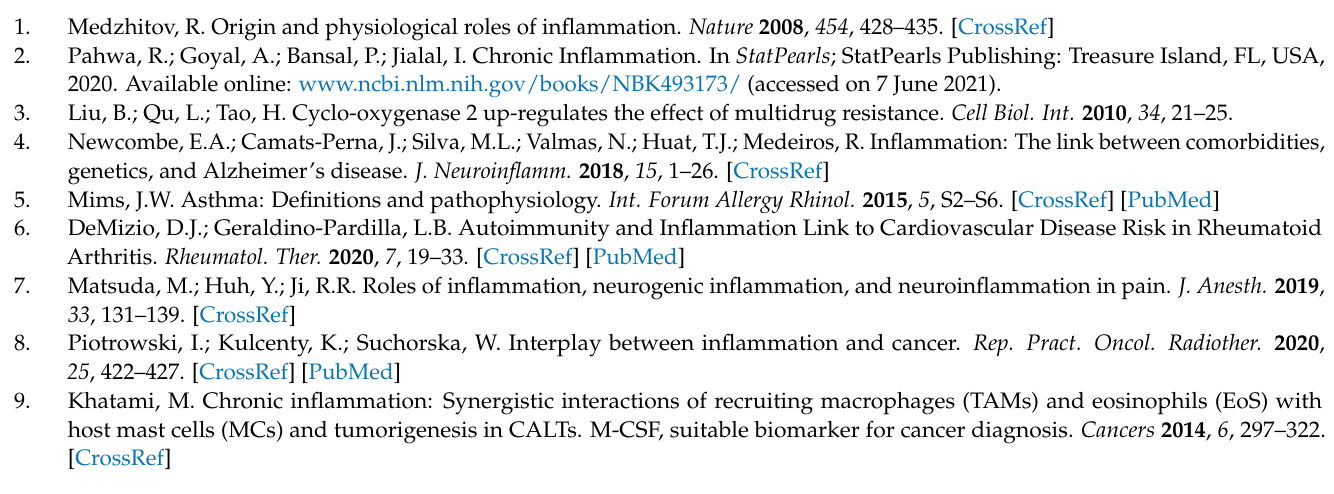
of 5 in CDCl 3 , Figure S3: 1 H NMR spectrum of 6a in CDCl 3 , Figure S4: 13 C NMR spectrum of 6a in CDCl 3 , Figure S5: 1 H NMR spectrum of 6b in CDCl 3 , Figure S6: 13 C NMR spectrum of 6b in CDCl 3 , Figure S7: 1 H NMR spectrum of 6c in CDCl 3 , Figure S8: 13 C NMR spectrum of 6c in CDCl 3 , Figure S9: 1 H NMR spectrum of 6d in CDCl 3 , Figure S10: 13 C NMR spectrum of 6d in CDCl 3 , Figure S11: 1 H NMR spectrum of 6e in CDCl 3 , Figure S12: 13 C NMR spectrum of 6e in CDCl 3 , Figure S13: 1 H NMR spectrum of 7 in CDCl 3 , Figure S14: 13 C NMR spectrum of 7 in CDCl 3 , Figure S15: The effect of 1,2-thiazine derivatives in comparison to the meloxicam on the transition half height (T 1/2 ) of the main phase transition of DPPC, Figure S16: The effect of 1,2-thiazine derivatives in comparison to the meloxicam on the transition enthalpy ( ∆ H) of the main phase transition of DPPC, Table S1: Values of DPPC phase transition temperatures (T M ) with studied compounds, Table S2: Values of DPPC transition half height (T 1 ) with studied compounds, Table S3: Values of 2 DPPC transition enthalpy changes ( ∆ H) with studied compounds, Figure S17: The intermolecular interactions between COX-1 and COX-2 and designed compounds, Table S4: Free energy of binding and intermolecular interactions of new 1,2-benzothiazine derivatives with COX-1, Table S5: Free energy of binding and intermolecular interactions of new 1,2-benzothiazine derivatives with